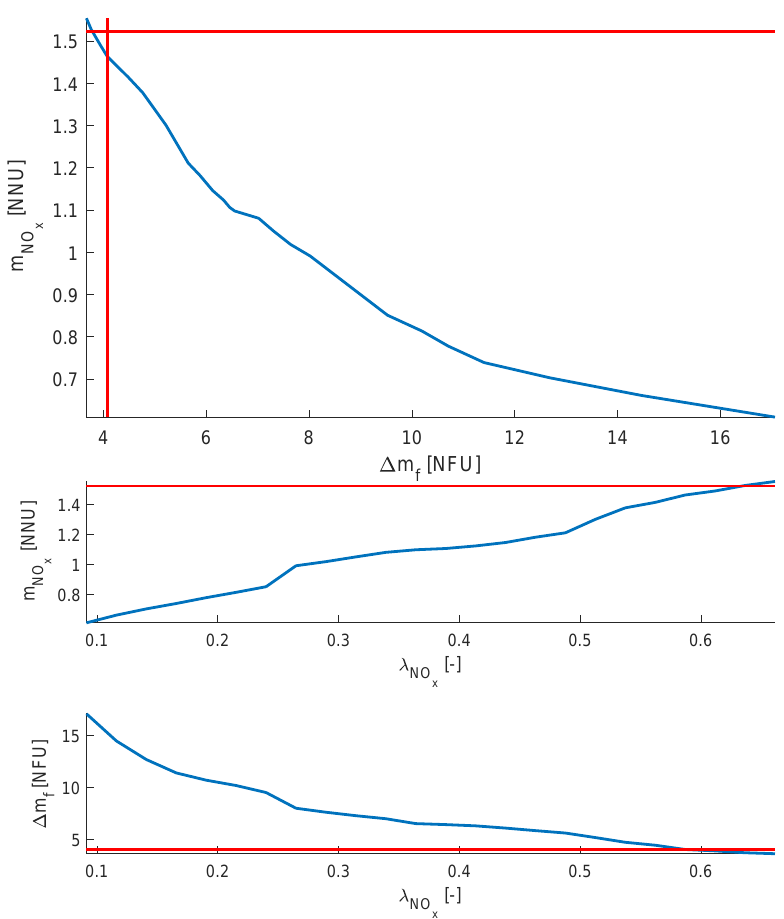
Figure 14. Results from simulations of the drayage cycle for a range of λ NO mark the result from the baseline strategy ( λ NO